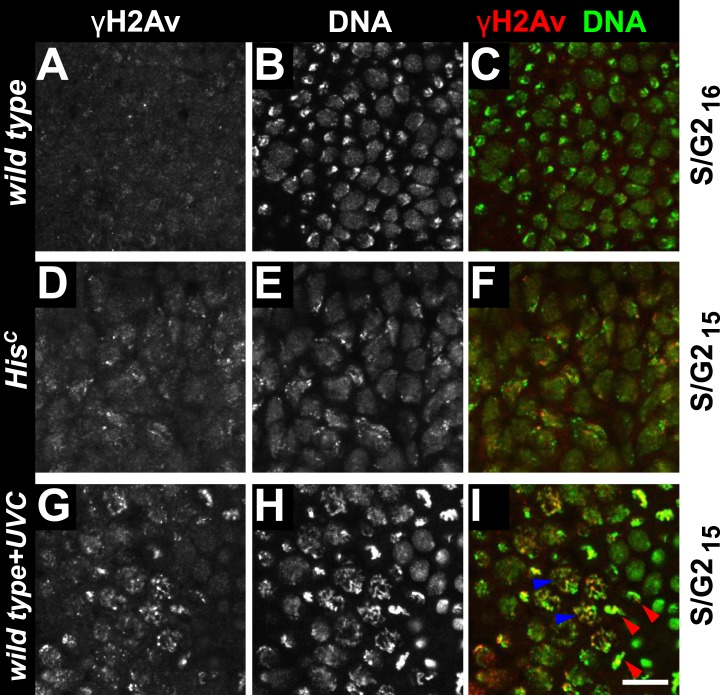
Mitotic entry with elevated γH2Av levels.Wild type sibling (A–C, G–I) and HisC mutant (D–F) embryos stained with DAPI (DNA) and antibodies against phosphorylated H2Av (γH2Av). (A–C) Wild type cells that were in S16/G216 display background levels of γH2Av staining. (D–F) Compared to wild type cells, HisC mutant cells in late S15 show increased γH2Av staining. (G–I) UVC-irradiated wild type cells show increased γH2Av staining. These irradiated cells entered into M15 (blue arrowheads point at prophase structures, red arrowheads point at metaphase structures), indicating that they repaired DNA damage and were no longer arrested by the DNA damage checkpoints. The elevated γH2Av staining in HisC mutant cells compared to wild type cells is therefore unlikely to reflect significant DNA damage. Scale bar: 10 µm.